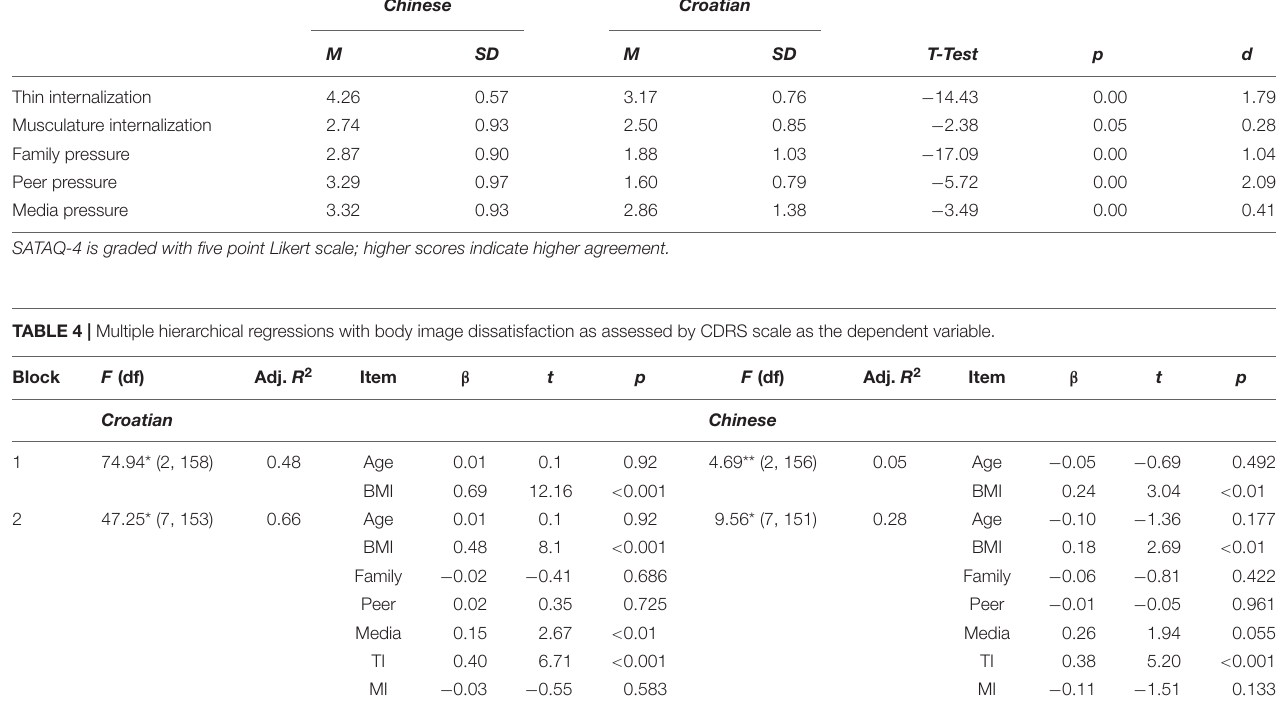
TABLE 3 | Comparison of sociocultural predictors of body image dissatisfaction between two cultural groups. Chinese